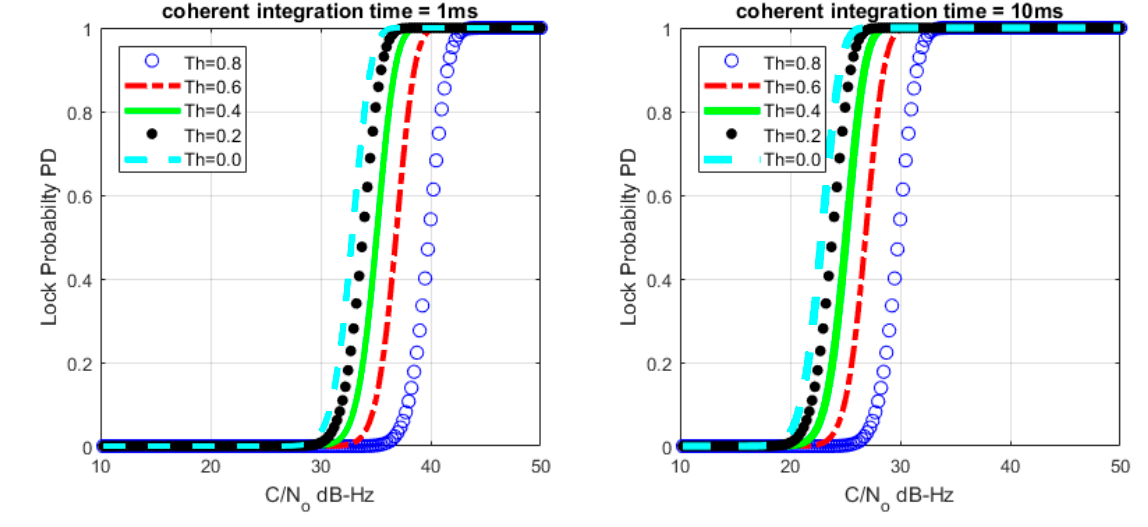
Figure 4. Loop lock probability under different C / N 0 with M = 20.